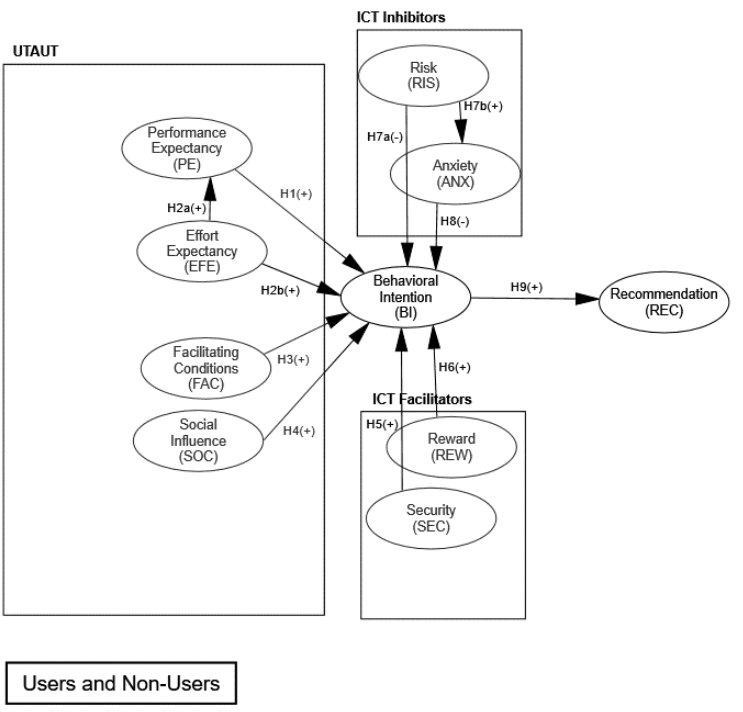
Figure 1. Hypothesized conceptual model.